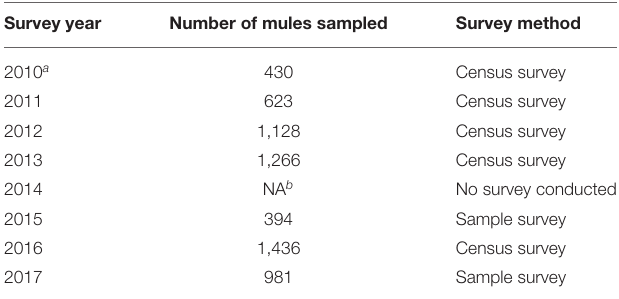
TABLE 1 | Number of mules sampled for annual cross-sectional survey of EZL and wounds, 2010–2017 (baseline and implementation